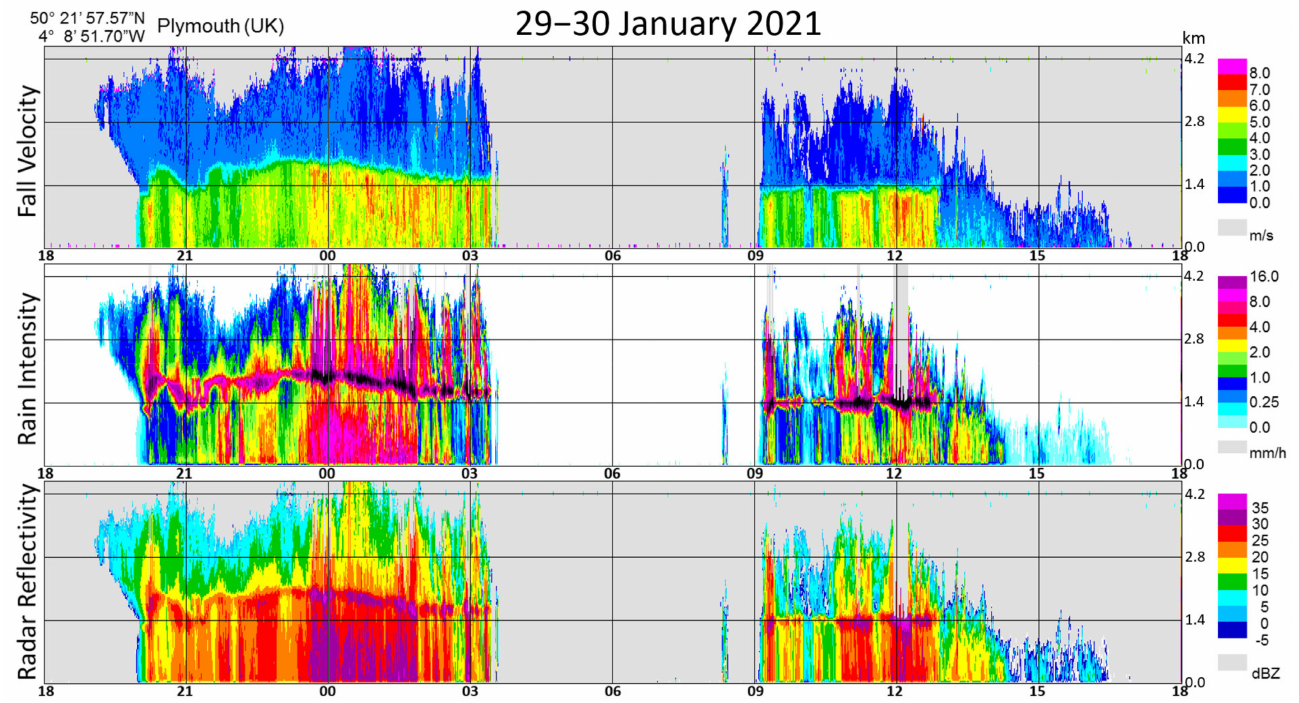
Figure 5. Example of a plot of data for 18:00 UTC on 29 January 2021 through to 18:00 UTC on 30 January 2021. The top plot shows the fall velocity, the middle plot the rain intensity and the bottom plot the radar reflectivity. The temporal sampling is 10 s, with 128 range bins with a range resolution of 35 m. The height of the melting layer is easily discernible by the change in the fall velocities and high rain rates and reflectivities about 1.4 km above the